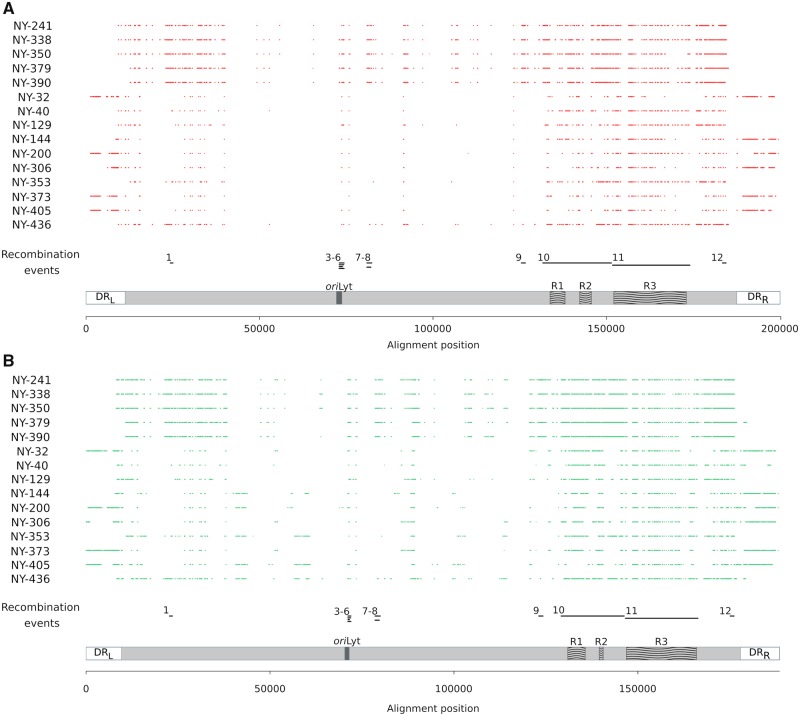
Ancestral components of NY cluster viruses. Site by site probability for the HHV-6A (A) and the HHV-6B-1 (B) ancestry components. Each line represent a NY cluster virus genome and each dot represents a SNP with a P > 0.80 to derive from the HHV-6A ancestry component (red) or the HHV-6B-1 ancestry component (green). Colors are the same as in Fig. 3. All the recombination events involving NY cluster viruses are also reported (see Table 1). Positions refer to HHV-6 and HHV-6B alignments, respectively. A schematic representation of HHV-6 genomes is also shown with landmark elements as in Fig. 2B.